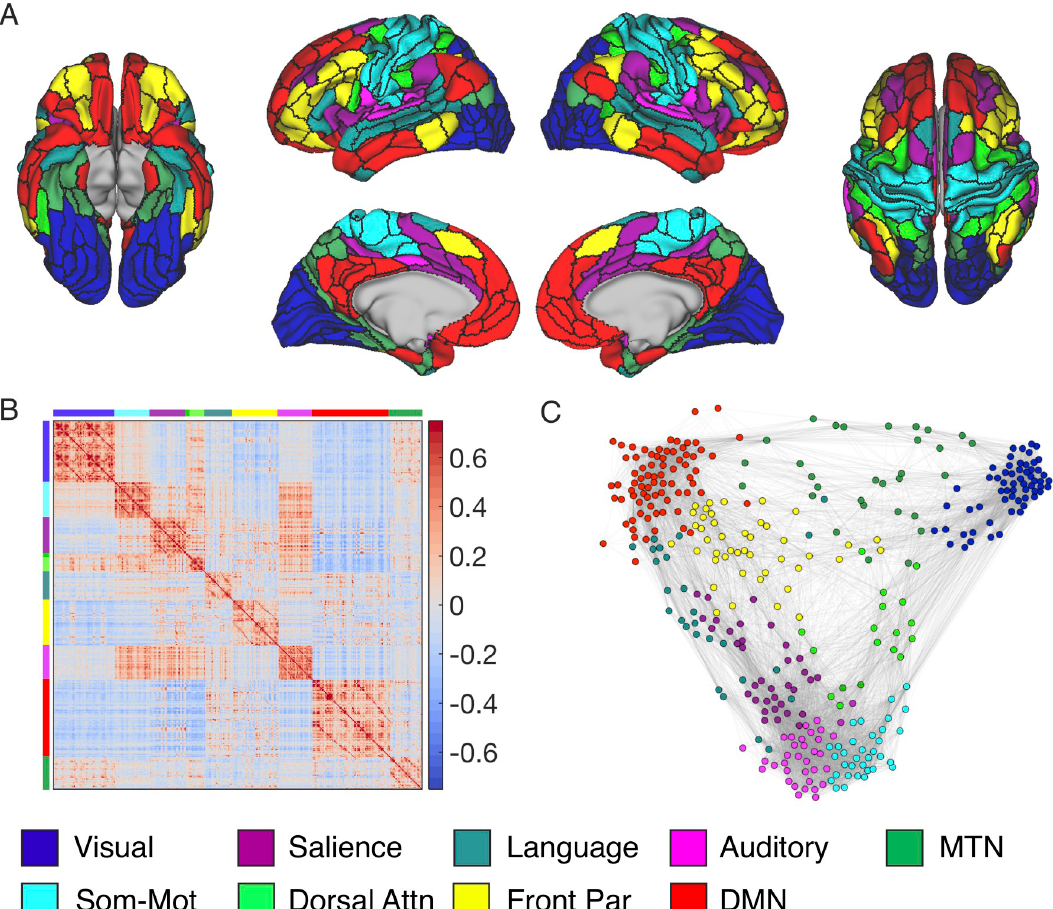
Fig 1. Louvain community detection identifies large-scale resting-state networks. (A) Inflated cortical surface, colored according to community membership. (B) Connectivity matrix reordered by community to demonstrate the community structure of the group-averaged brain. Colors along the axis demonstrate which rows/columns belong to a given community. Color bar represents Fisher Z-transformed correlation values. (C) Force-directed graph of the group-averaged networks color coded by community membership of the selected partition created using the ForceAtlas2 algorithm [54]. Attn, attention; DMN, default mode network; Front Par, frontoparietal; MTN, medial temporal network; Som-Mot, somatomotor. Data can be found at https://github.com/ajbarn/